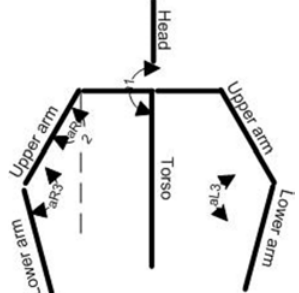
Figure 8. Model of the upper body used for pose estimation.